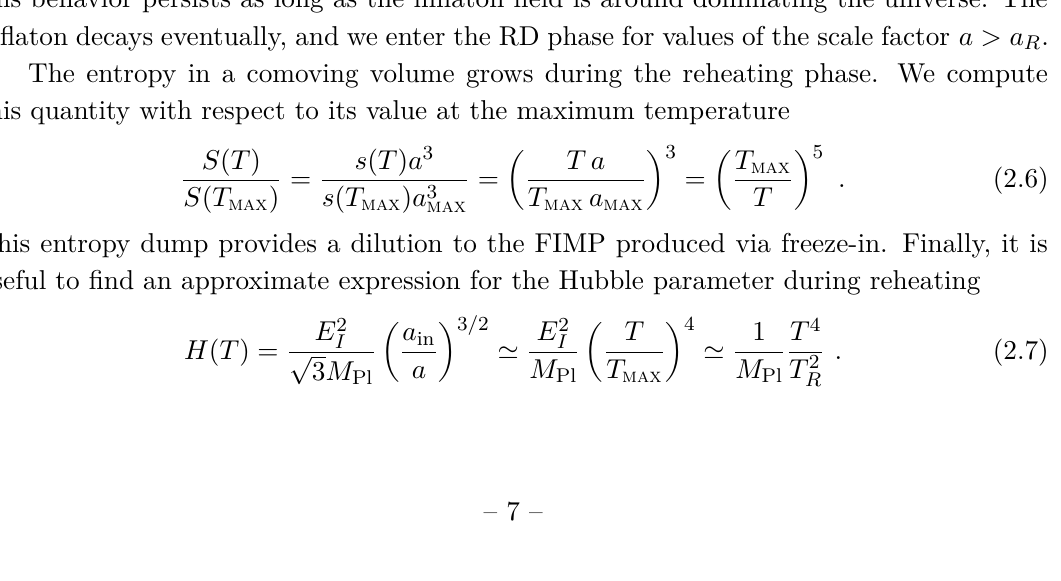
and T to the same values chosen in figure I R